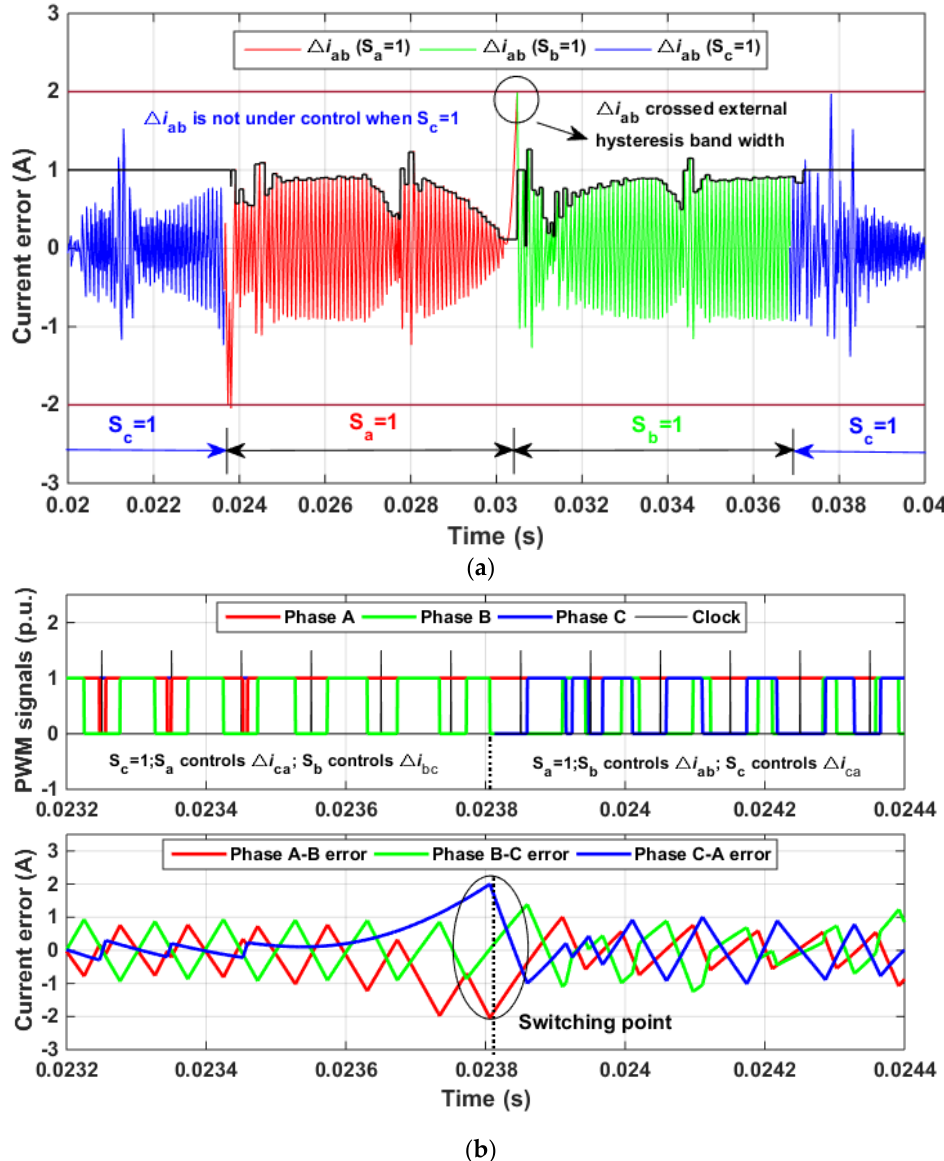
Figure 14. The performance of the current errors obtained by S-FHCC. ( a ) Δ i ab obtained by S-FHCC; ( b ) detailed current errors when Δ i ab exceeds its limit.